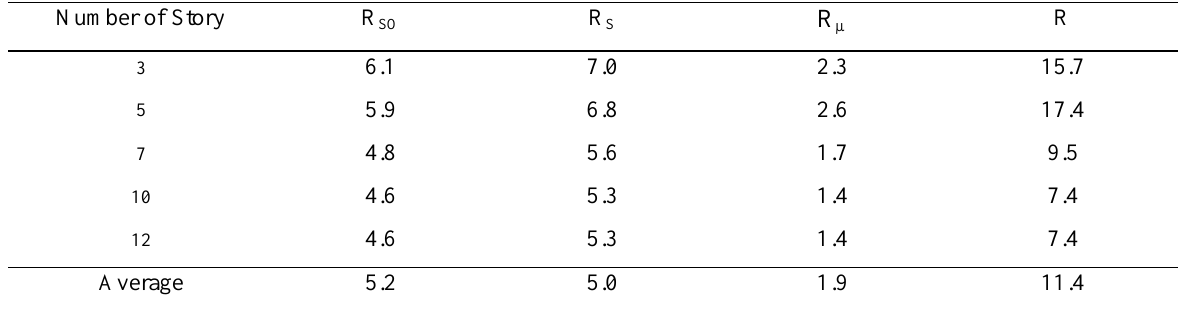
Table. 7. Average of overstrength, ductility and response modification factors of KO.